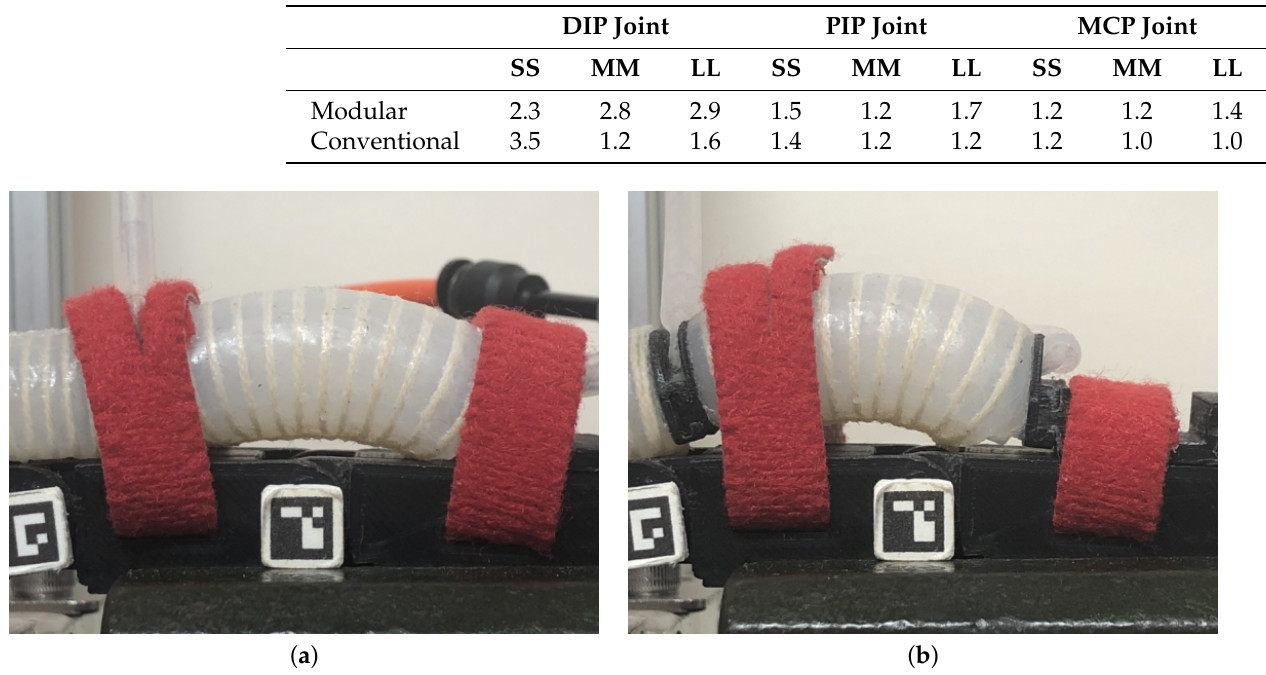
Figure 12. Maximal torque at 200 kPa for different size dummy finger. ( a ) Modular type; ( b ) conven- tional type. Table 3. R torque (the ratio of the torques of matched pair and mismatched pair).